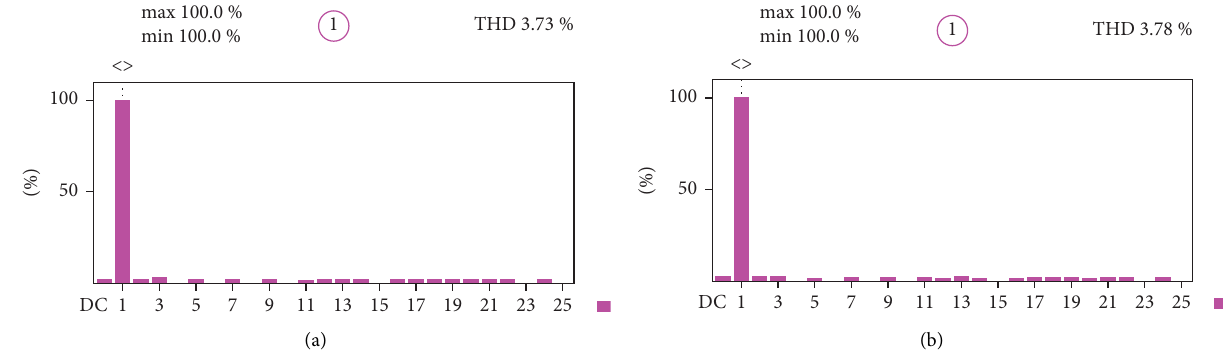
Figure 24: Experimental FFT of line voltage at M � 1.0. (a) SVPWM-I. (b) SVPWM-II.